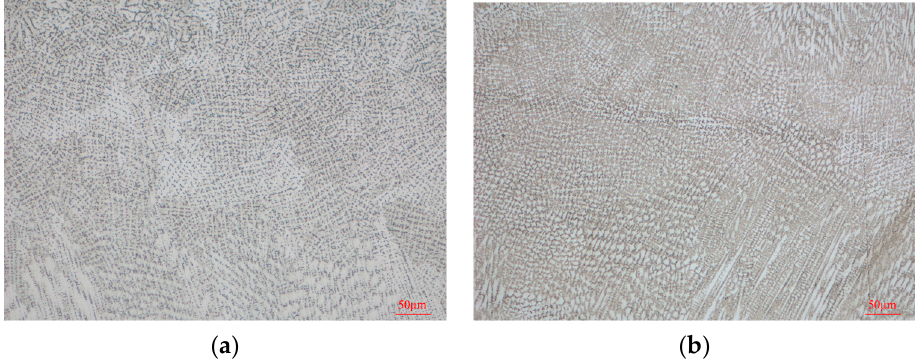
Figure 7. Metallographic photograph of powder deposition samples. ( a ) New powder (H0) depos- ited metallographic photos; ( b ) four times recovery (H4) deposited metallographic photos. metallographic photos; ( b ) four times recovery (H4) deposited metallographic